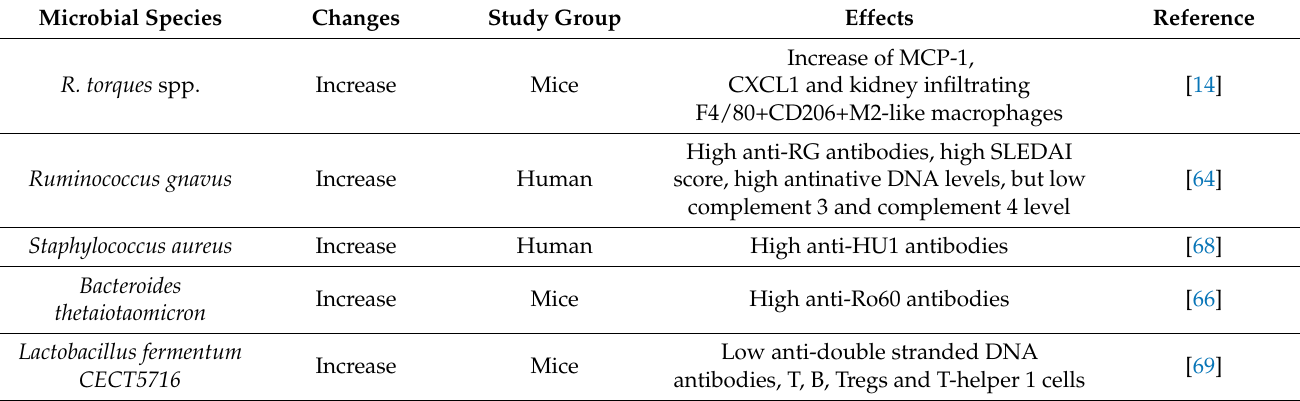
Figure 1. Summary of defective barrier function caused by gut dysbiosis that promote to lupus nephritis. IAP: intestinal alkaline phosphatase, LPS: lipopolysaccharides, TJ: tight junction, IL: inter- leukin, TNF: tumor necrosis factor, IFN: interferon, NF- κ B: nuclear factor kappa beta, TLR: toll-like receptor, IC: immune complexes, : Increment